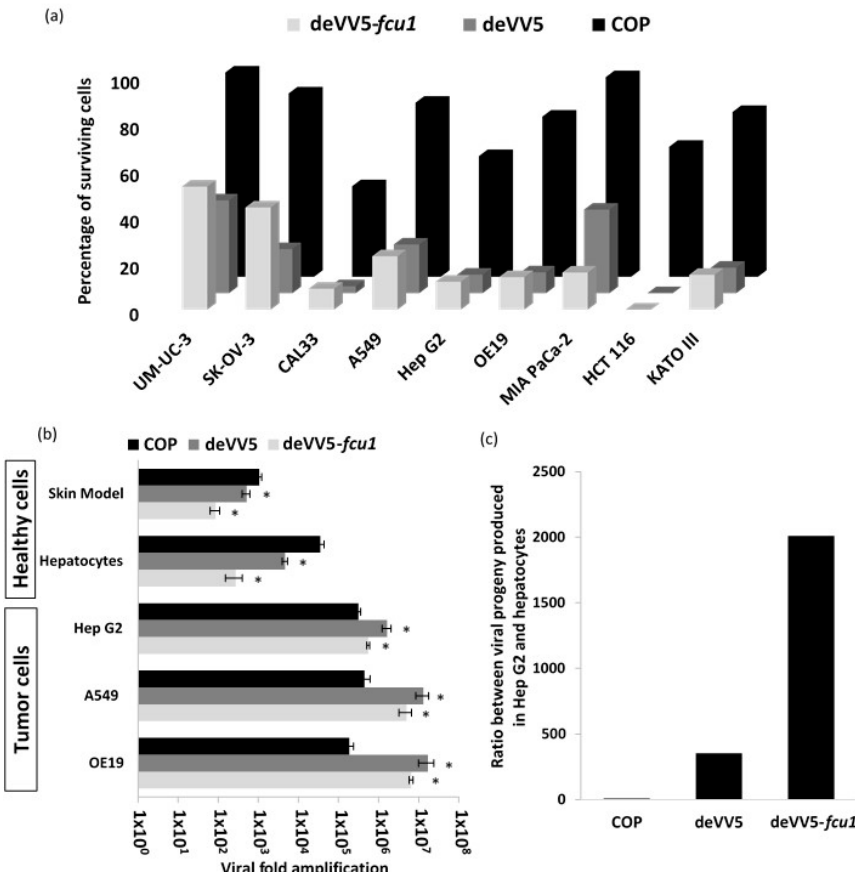
Figure 5. Both chimeric and recombinant chimera are able to infect and kill cancer cells leaving primary cells intact. ( a ) Oncolytic activities of COP, deVV5 and deVV5- fcu1 by measuring the